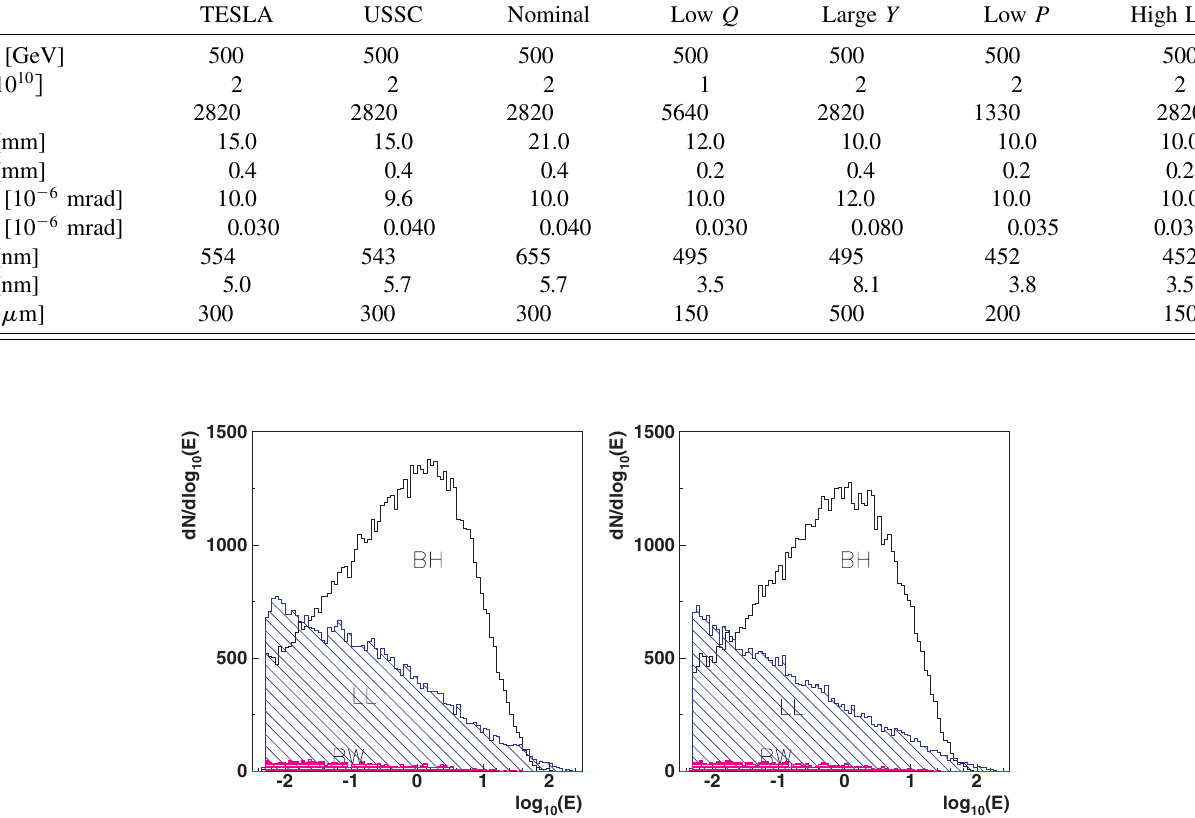
(cid:3) E (cid:4) spectra for the three incoherent pair creation processes, BH, LL, and BW modeled in GUINEA-PIG (left plot) FIG. 3. (Color) log 10 and CAIN (right plot), E being in